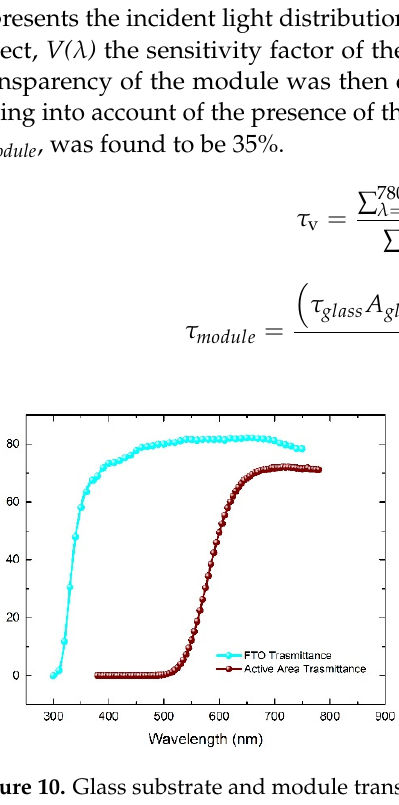
Figure 9. Trend of all electrical parameters during the 1000 h test ( A ) at 60 °C, ( B ) at 85 °C and ( C ) under light soaking.